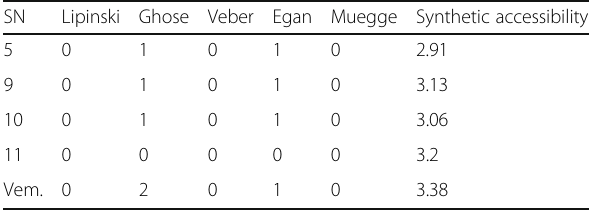
Table 3 Predicted drug-likeness based on the Lipinski, Ghose, Veber, Egan, and Muegge rules and synthetic accessibility of the selected compounds SN Lipinski Ghose Veber Egan Muegge Synthetic